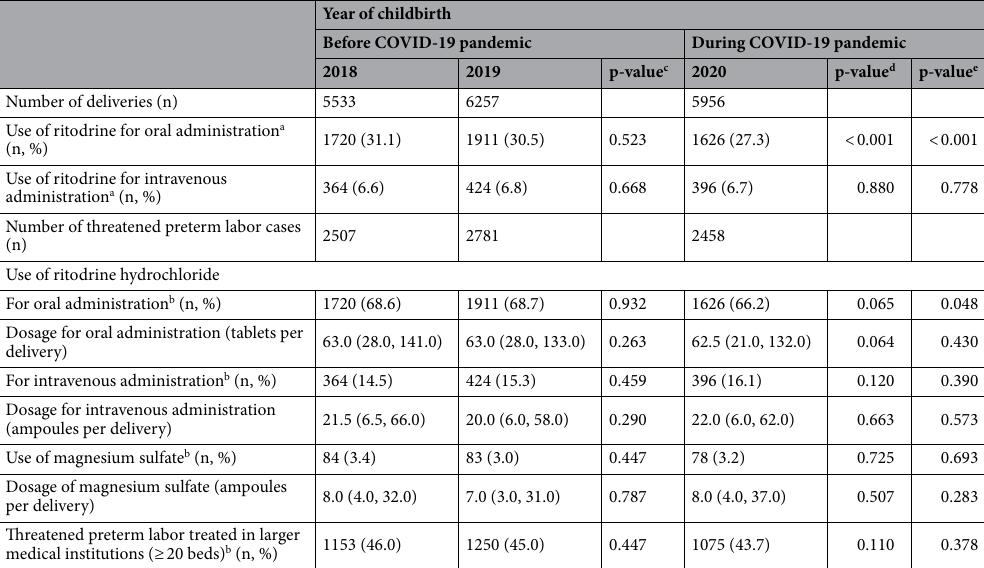
Table 3. Use of tocolytic agents in 2018, 2019, and 2020 among all deliveries and cases with threatened preterm labor. Uses of medicines are described in number (a: % for the number of deliveries, b: % for the number of threatened preterm labor cases), and their dosages are described in median (25th percentile, 75th percentile). P-values of Pearson’s chi-square test or Wilcoxon’s rank sum test c: between 2018 and 2019, d: between 2018 and 2020, and e: between 2019 and 2020 are shown. We used a P value of 0.0167 to indicate significance to correct for